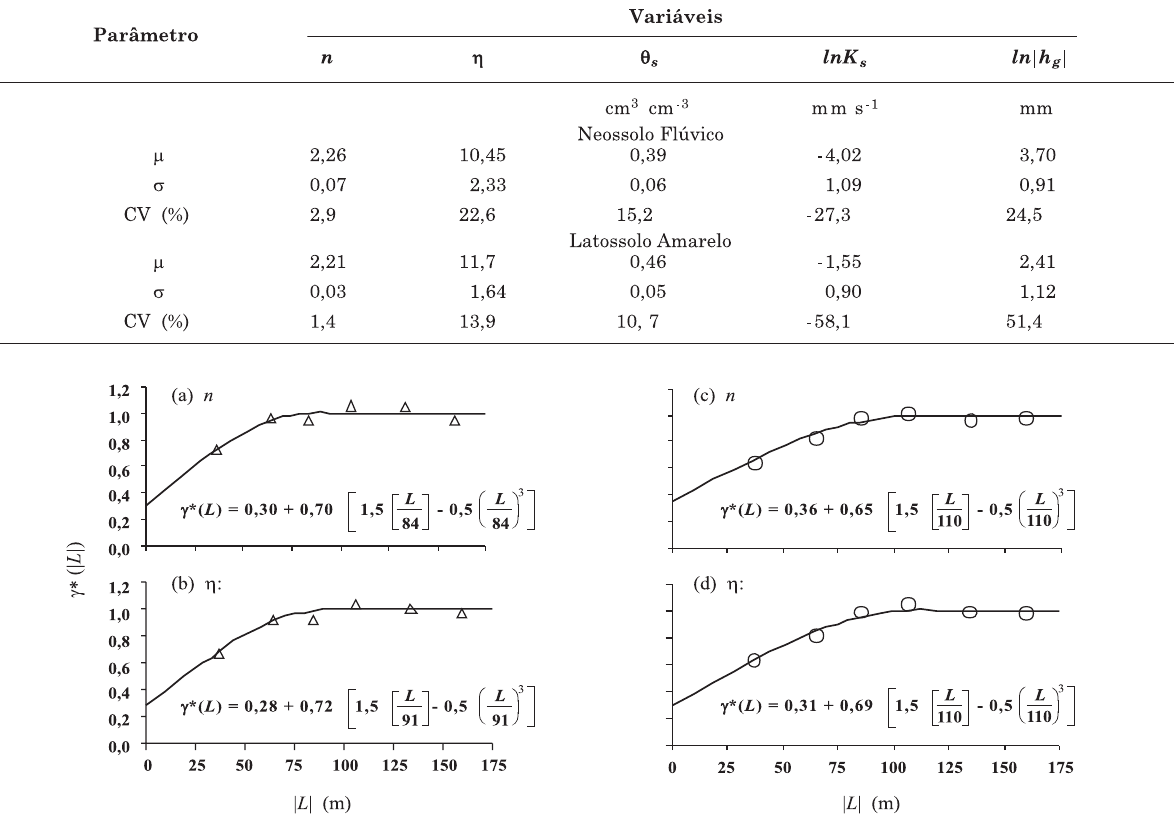
Figura 3. Semivariogramas experimentais e teóricos normalizados dos parâmetros de forma n e ηηηηη . Neossolo Fluvico (a) e (b) e Latossolo Amarelo (c) e